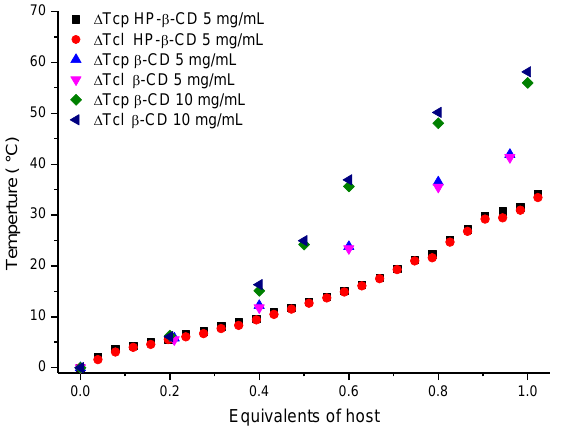
Figure 4. ∆ T cp of P(EtOx-stat-AdamantanOx), plotted as a function of the host content. Figure 4. ∆T cp of P(EtOx-stat-AdamantanOx), plotted as a function of the host content.